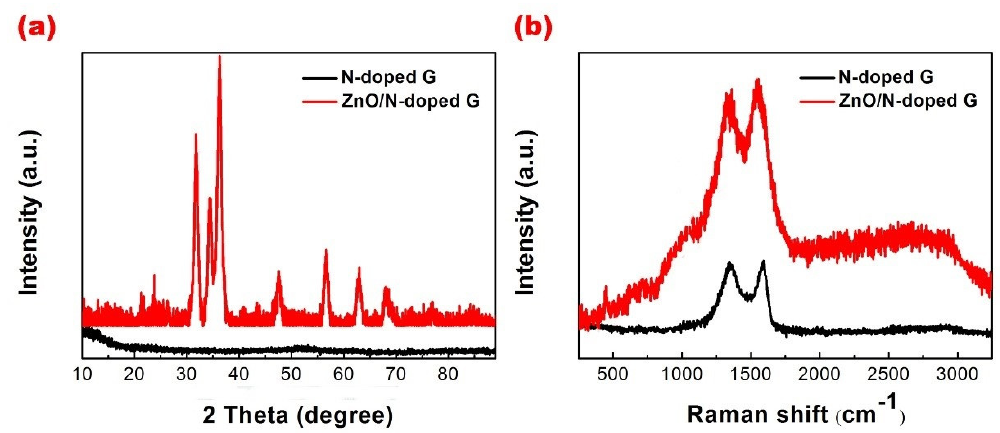
Figure 2. ( a ) XRD patterns of NDG and the ZnO/NDG composite. ( b ) Raman spectra of NDG and the ZnO/NDG composite.